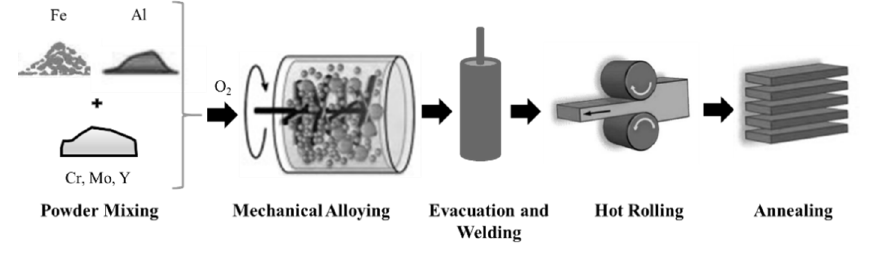
Figure 1. Material preparation process.